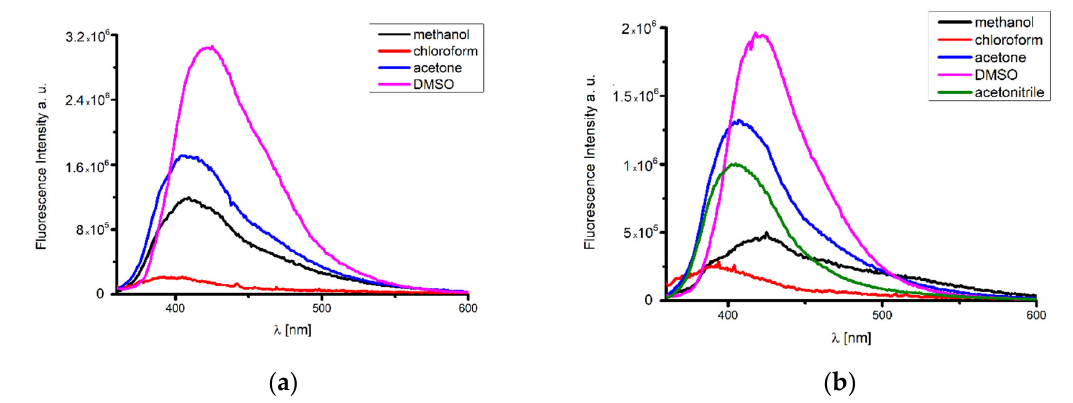
Figure 10. Emission spectra of the ( a ) K1 and ( b ) K2 complexes’ solutions; λ ex = 350 nm chloroform, acetone, methanol, acetonitrile, DMSO (3.3 × 10 − 6 mol/dm 3 , RT).